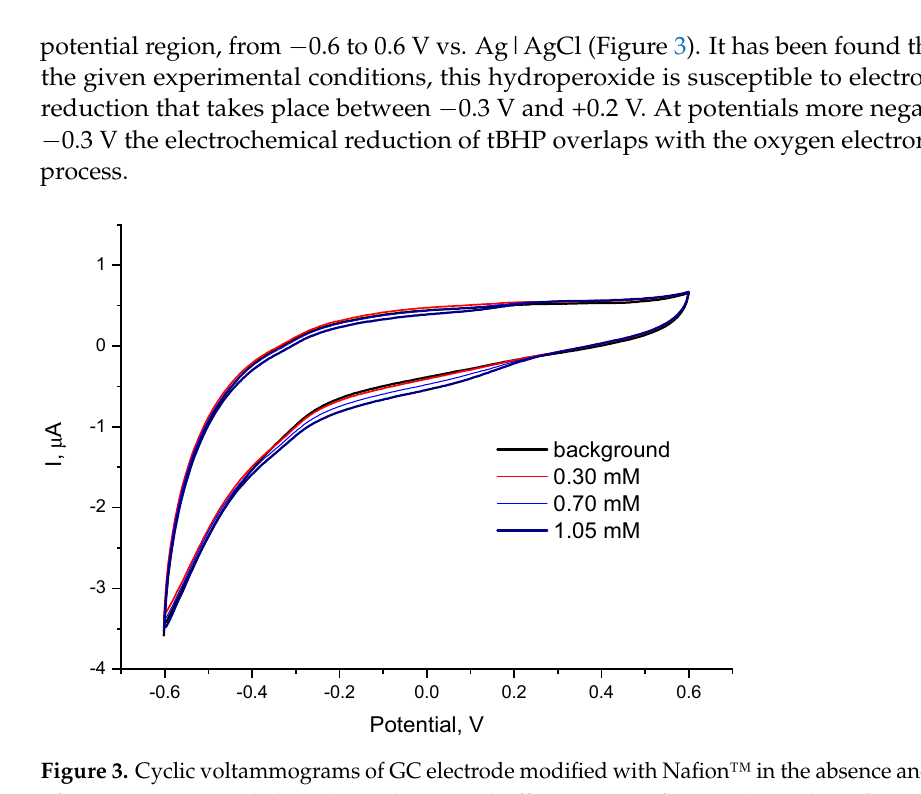
12 Figure 2. EIS spectra (Nyquist plot) of GC electrode, modified with Nafion™ (1) and with Co-g- C 3 N 4 —Nafion composite (2); reference electrode Ag|AgCl, sat KCl; electrolyte 0.1 M KCl with 5 mM